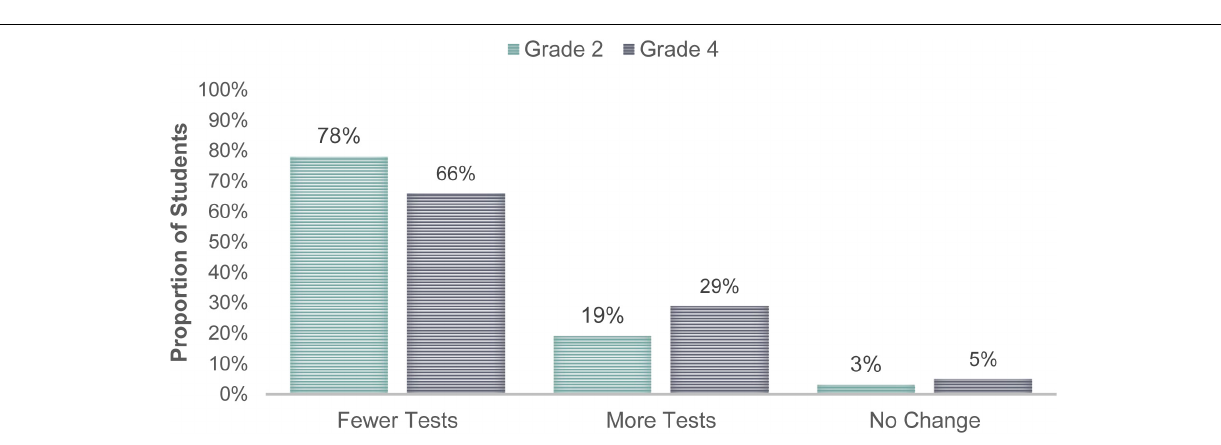
FIGURE 4 | Percentage of the students with changes to the recommended number of tests to be administered based on the